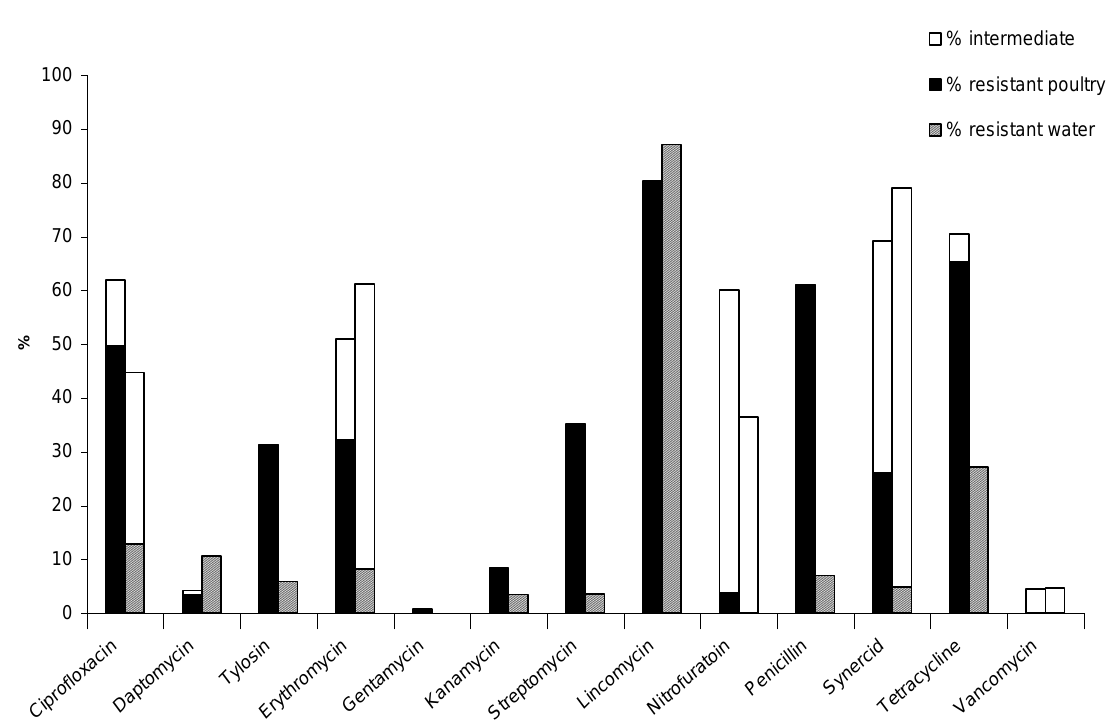
Figure 1. Percent antibiotic resistance for enterococci. Enterococci isolated from poultry litter and environmental water samples were tested against a panel of 16 antimicrobials. Percent resistant enterococci from poultry litter (solid bar) and water (hatched bar) are shown for each antimicrobial; intermediate resistant isolates for each source are shown in the open bars. All isolates were susceptible to linezolid and tigecycline; only one isolate ( E. faecalis from water) was resistant to chloramphenicol (data not